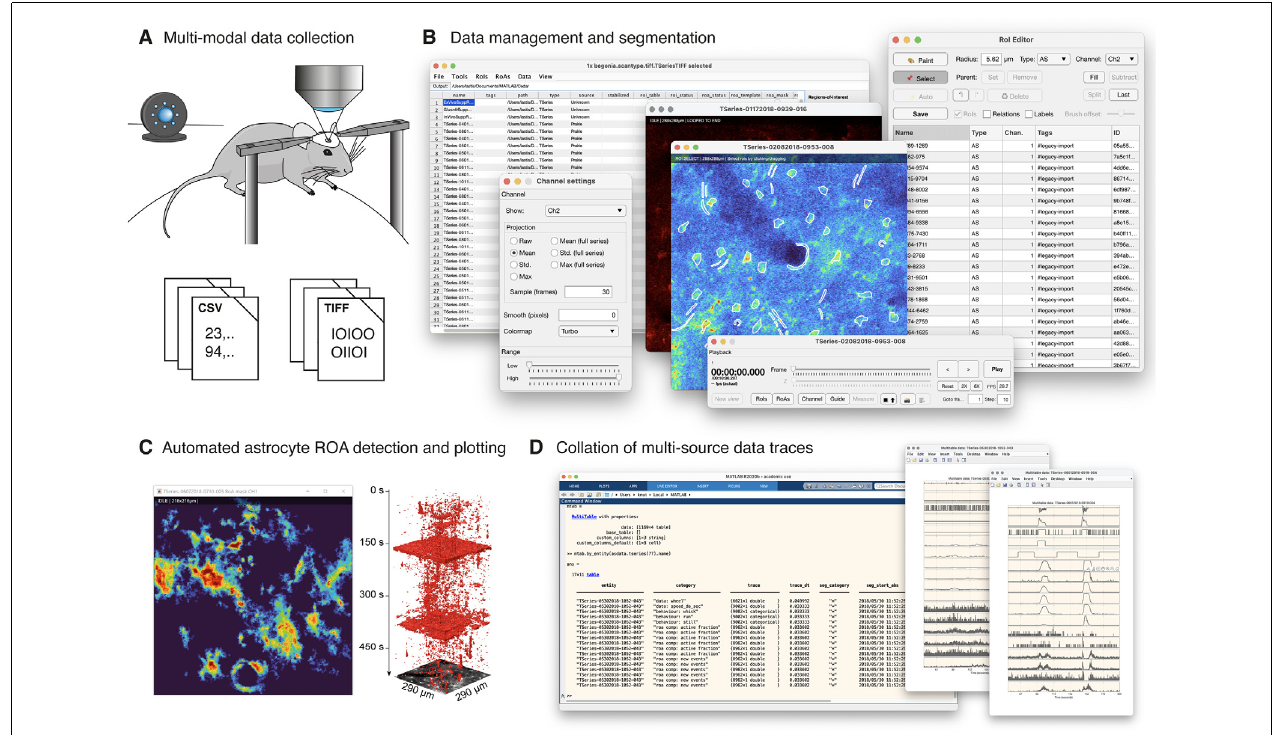
FIGURE 1 | Begonia workflow. (A) Acquisition of multi-modal data. Movement from a running wheel and surveillance video from an infrared-sensitive camera is typically recorded alongside two-photon imaging data. (B) Begonia provides an editor for project-specific manual tasks, data and metadata management, and manual ROI segmentation of the imaging data. (C) The region-of-activity (ROA) algorithm provides an automated or semi-automatic detection of astrocytic Ca 2+ signals in the field-of-view or inside manually segmented ROIs or groups of manually segmented ROIs. (D) MultiTable provides a way to collate, synchronize and segment time series traces from ROIs, ROA, and custom sources on